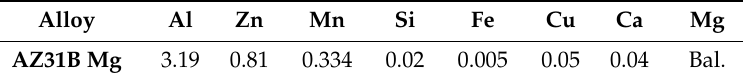
Table 1. Chemical composition of AZ31B Mg alloy (wt%).